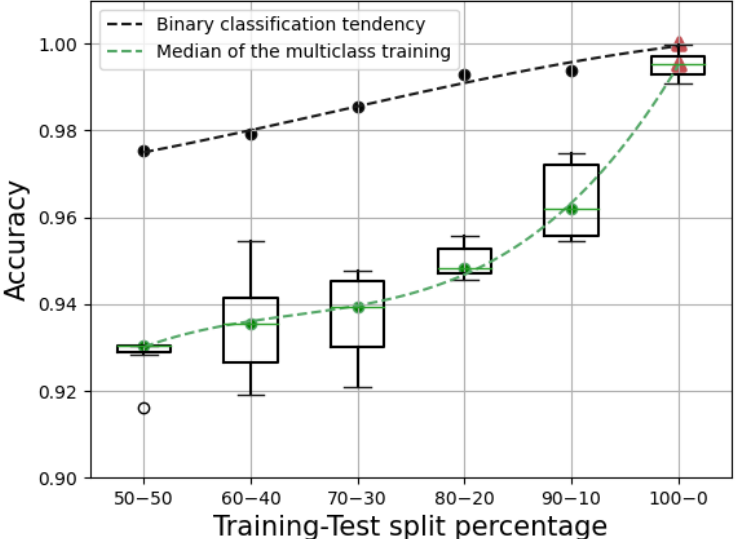
Figure 7. Performance of the complete model for different percentages of training data split. Boxplot of F1 score of a ten folds test; green dotted line shows the increase in the median adjusted to a quadratic function. The black dotted line shows the tendency of the best model for each percentage transferred to classify binary classes, and the red triangles account for the performance reached with 100% of the dataset as the training